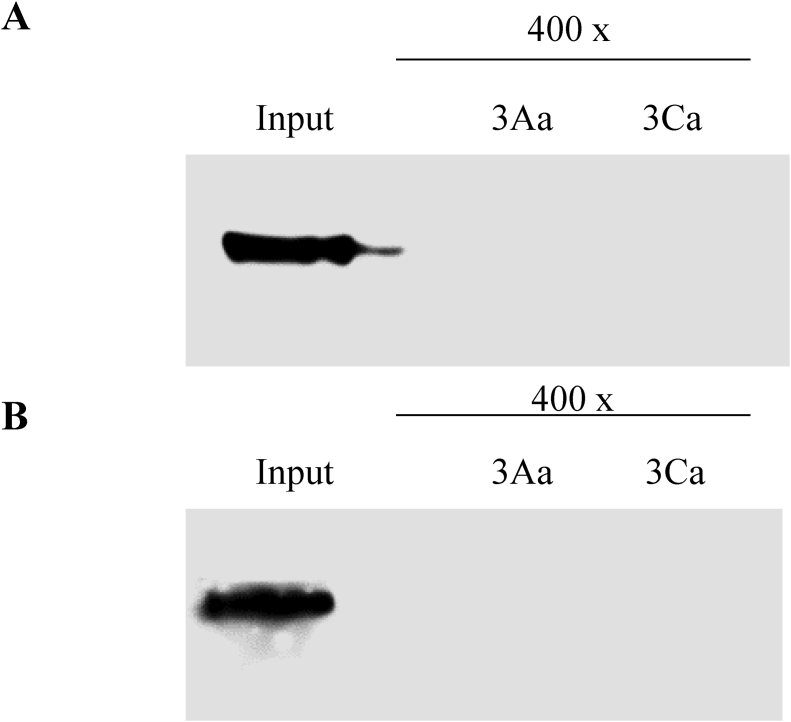
Control experiments of the protein precipitation on binding assays. Biotinylated chymotrypsin-activated Cry3Aa (A) or Cry3Ca (B) proteins were incubated in absence of C. puncticollis BBMV and in the presence (400x) of unlabeled chymotrypsin-activated proteins. Input indicates biotinylated Cry3 proteins without BBMV.